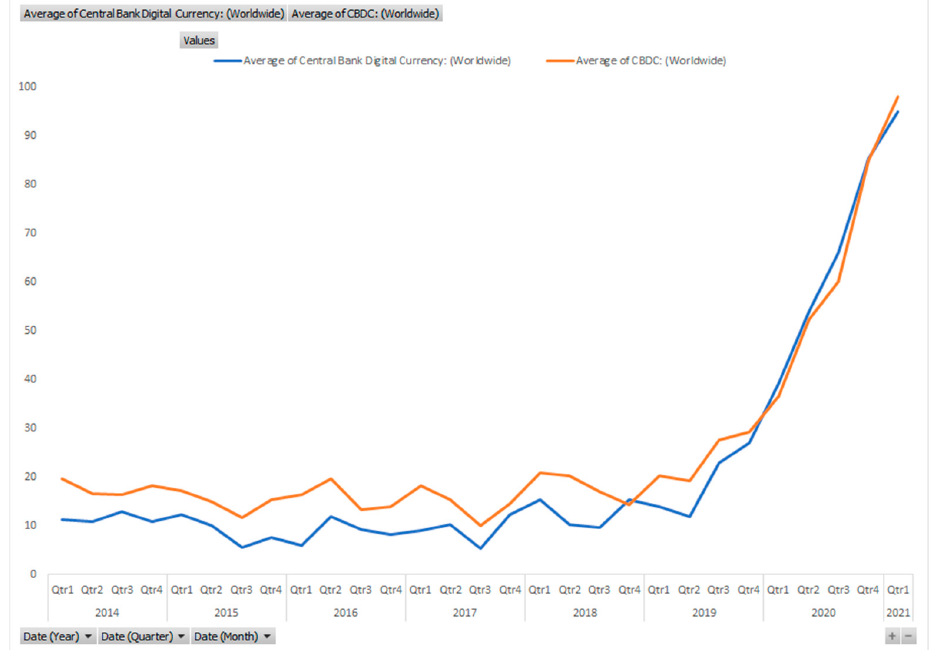
Figure 2. Evolution of search interest in CDBC and Central Bank Digital Currency (CBDC), world- wide, in Google Trends, monthly data averaged by quarter; Source: authors’ own.